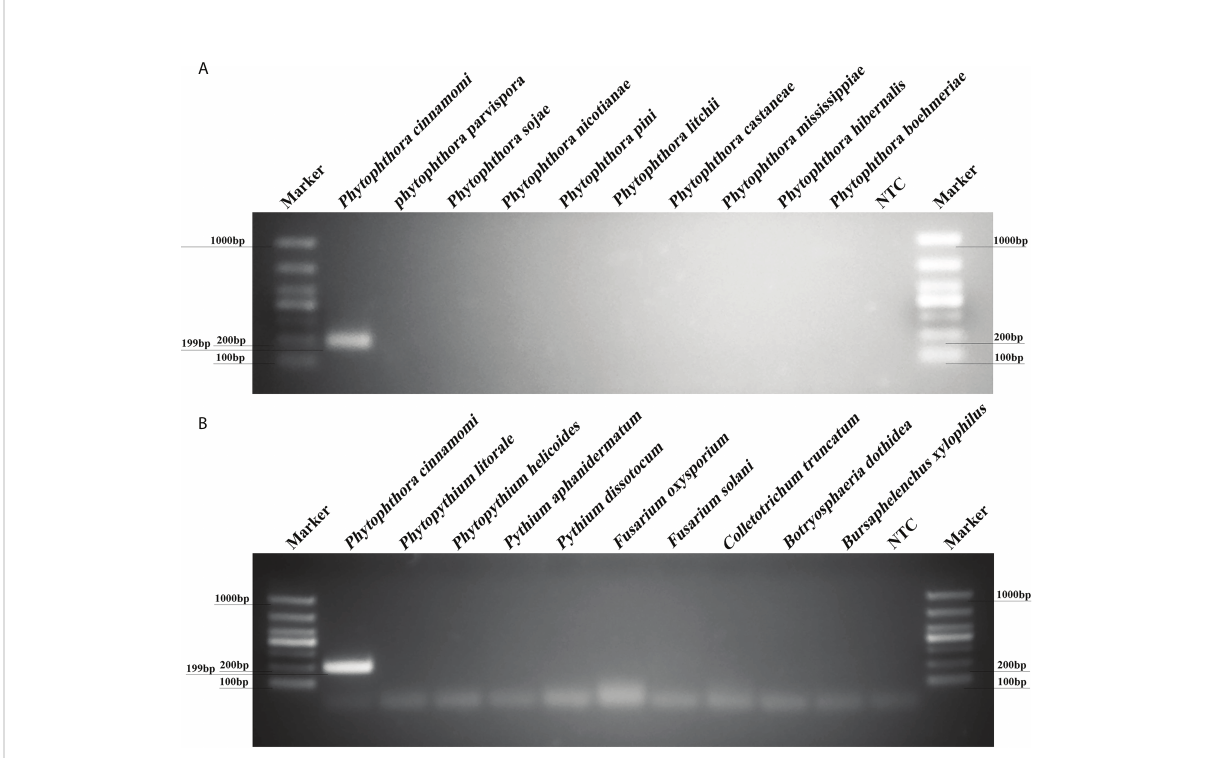
FIGURE 2 A new target gene ( Pcinn13739 ) was found to be speci fi c for the detection of Phytophthora cinnamomi . (A) Evaluation of speci fi city for a PCR assay based on a novel target ( Pcinn13739 ) in Phytophthora species. Amplicons that were approximately 199 bp in size were detected by PCR in reactions containing gDNA from P. cinnamomi isolates. No PCR amplicons were observed for other Phytophthora species. (B) A 199 bp band was detected in P. cinnamomi but not in other Phytopythium , Pythium , fungi, Bursaphelenchus ; similarly, no bands were detected in the negative controls NTC, negative control; Marker DL1000 (Takara Shuzo, Shiga, Japan). Each group of experiments was repeated in